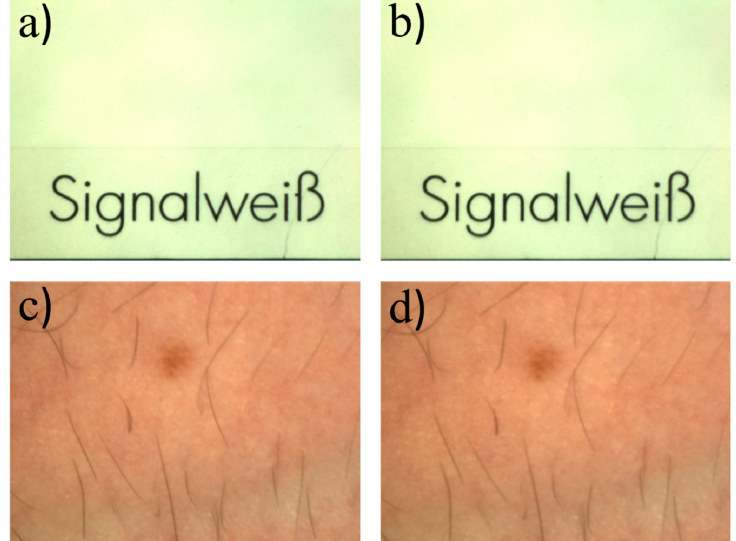
Figure 6. ( a ): Picture of the RAL color “Signalwei β ” (signal white) taken in a dark laboratory and ( b ) while neon light is turned on in the same laboratory. ( c ) Picture of human skin with a nevus and a vein in the bottom part of the image taken in a dark laboratory. ( d ) Picture of the same area of human skin taken while neon light is turned on in the laboratory (at least 525 lx). Both pictures were taken with activated cross polarization and the hand was fixed, so that both images show the same area. The images look very similar. This shows that the system is mostly independent of ambient lighting